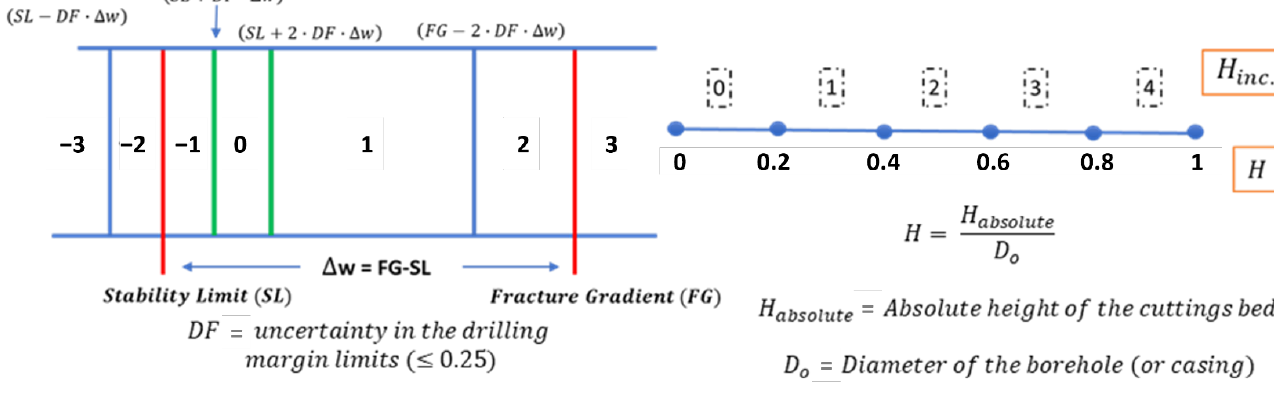
Figure 7. Functional value assignments for the state parameters.